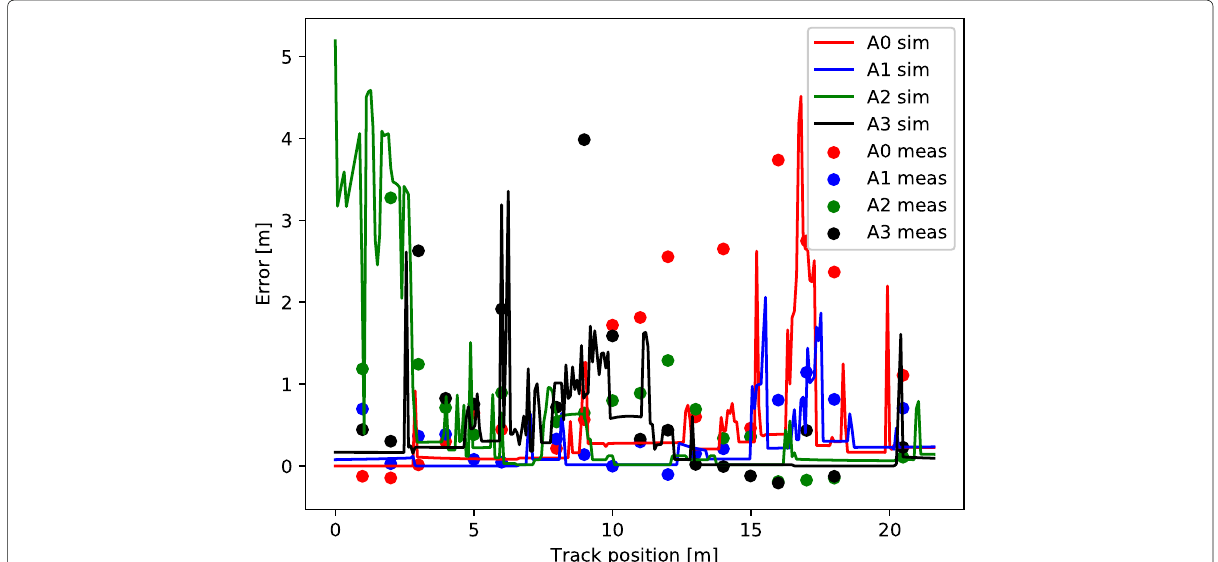
Fig. 4 Graphical representation of ranging errors for simulated trajectory (lines) and measured trajectory